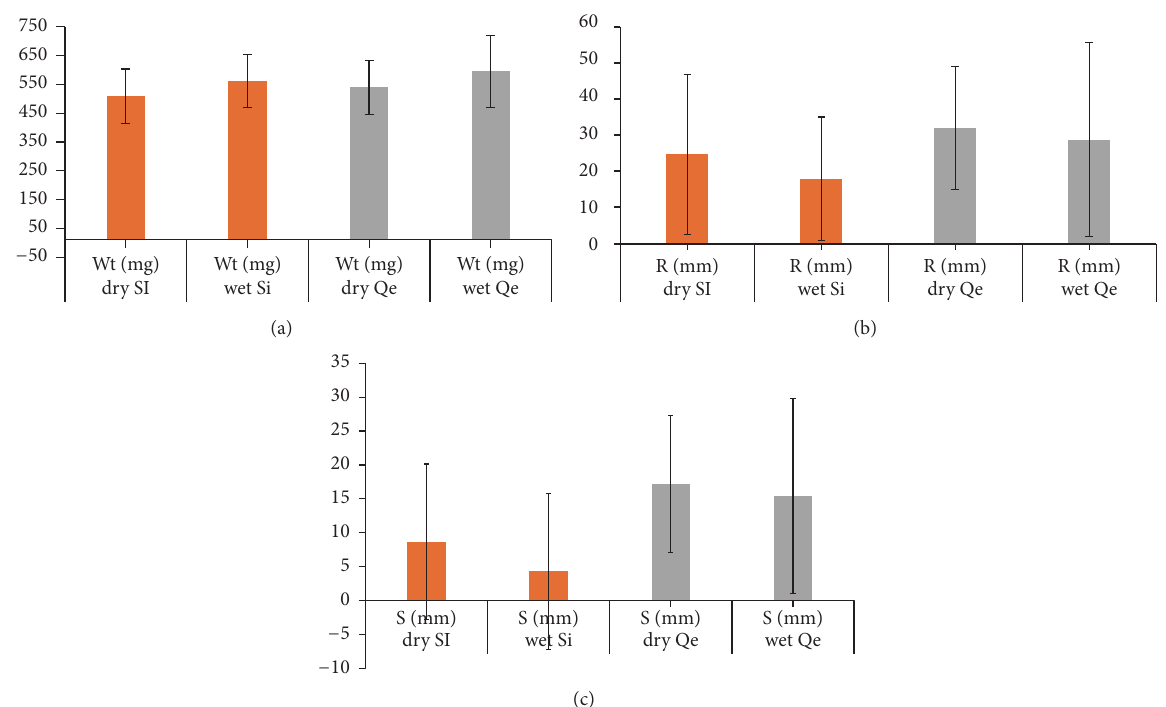
Figure 13: Effect of dry and wet QE and Si powders on the (a) weight (mg) and (b and c) length (mm) of roots (R) and shoots (S) of chickpea saplings after one week ( n = 12–18).